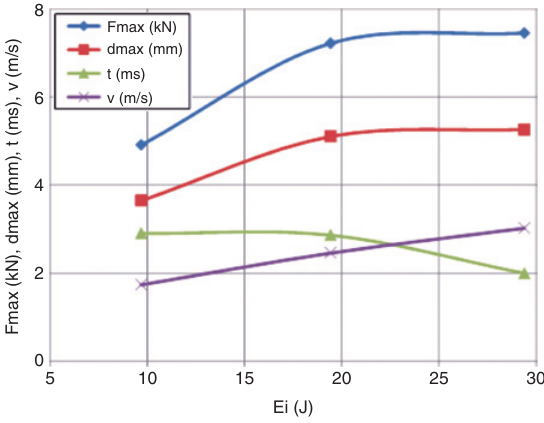
Figure 4 Variation of the maximum load, maximum deflec- tion, contact time and impact velocity vs. impact energy of LJ-60